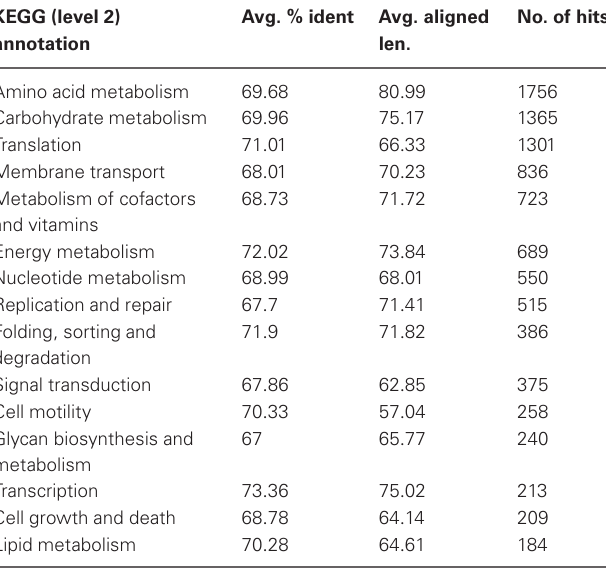
Table 4 | List of major KEGG families.